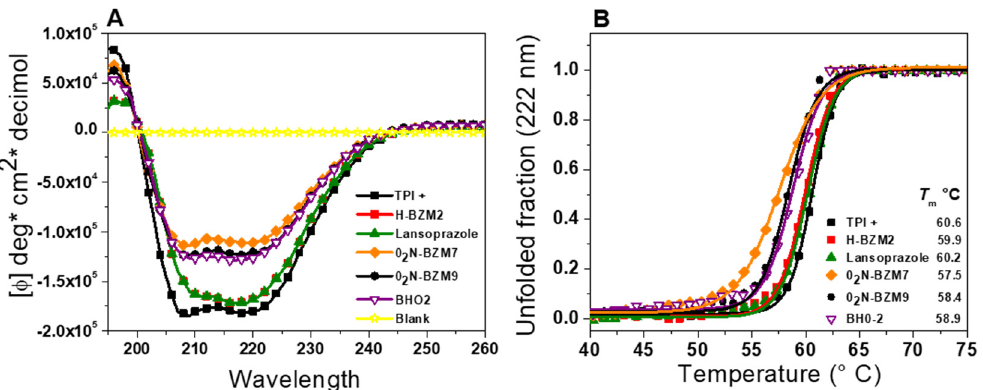
Figure 7. Spectroscopic characterization of TPI from G. lamblia . ( A ) Far-UV circular dichroism (CD) spectra and ( B ) thermal stability of the TPI protein. Changes in molar ellipticity were monitored by circular dichroism when the temperature was increased progressively from 35 to 70 ◦ C at 1 ◦ C / 2.5 min. In both assays, the protein was adjusted to 0.2 mg / mL in 50 mM phosphate bu ff er (bu ff er P) and incubated with any of the four compounds at the IC 50 concentration of each inhibitor for 2 h at 37 ◦ C prior to measurement. The experiment is representative of triplicate experiments.